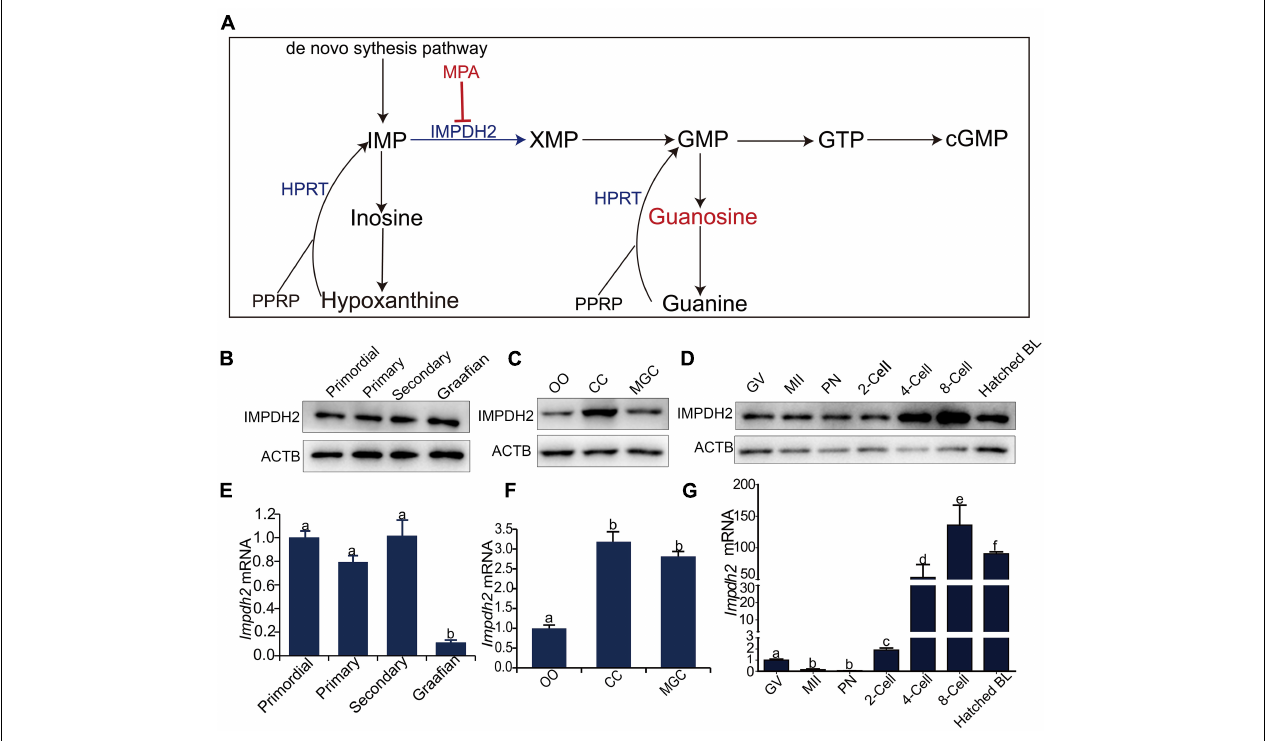
FIGURE 1 | Dynamic expression of Impdh2 in oocytes, granulosa cells, and preimplantation embryos. (A) Schematic illustration of the guanosine nucleotides biosynthesis. (B–D) WB detection of the expression of IMPDH2 protein in oocytes isolated from the primordial, primary, secondary, and Graafian follicles (B) ; oocytes (OO), cumulus cells (CC), and mural granulosa cells (MGC) isolated from the large antral follicles (C) ; oocytes at GV- and MII stages, and preimplantation embryos at different developmental stages (D) . (E–G) qRT-PCR comparison of the expression Impdh2 mRNA in oocytes isolated from the primordial, primary, secondary, and Graafian follicles (E) ; oocytes (OO), cumulus cells (CC), and mural granulosa cells (MGC) isolated from the large antral follicles (F) ; oocytes at GV- and MII stages, and preimplantation embryos at different developmental stages (G) . Bars without letters in common are considered to be significantly different ( P <